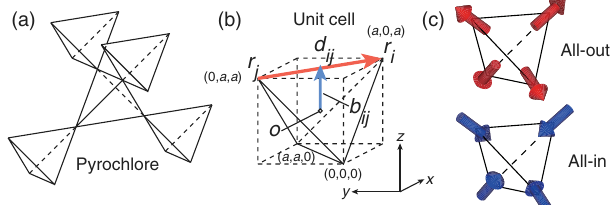
FIG. 2. Magnetic structure and notations for spin-orbit inter- action on pyrochlore lattice. (a) Pyrochlore lattice structure, (b) definition of effective spin-orbit couplings on pyrochlore lattices, and (c) all-in – all-out magnetic-moment configuration. In (b), the vectors ~d and ~b are illustrated for a specific bond. ij ij The vector ~d points from the j th site ~r to the i th site ~r , and the ij j i vector b points from the center of the unit tetrahedron O to the ij midpoint between ~r and ~r i j